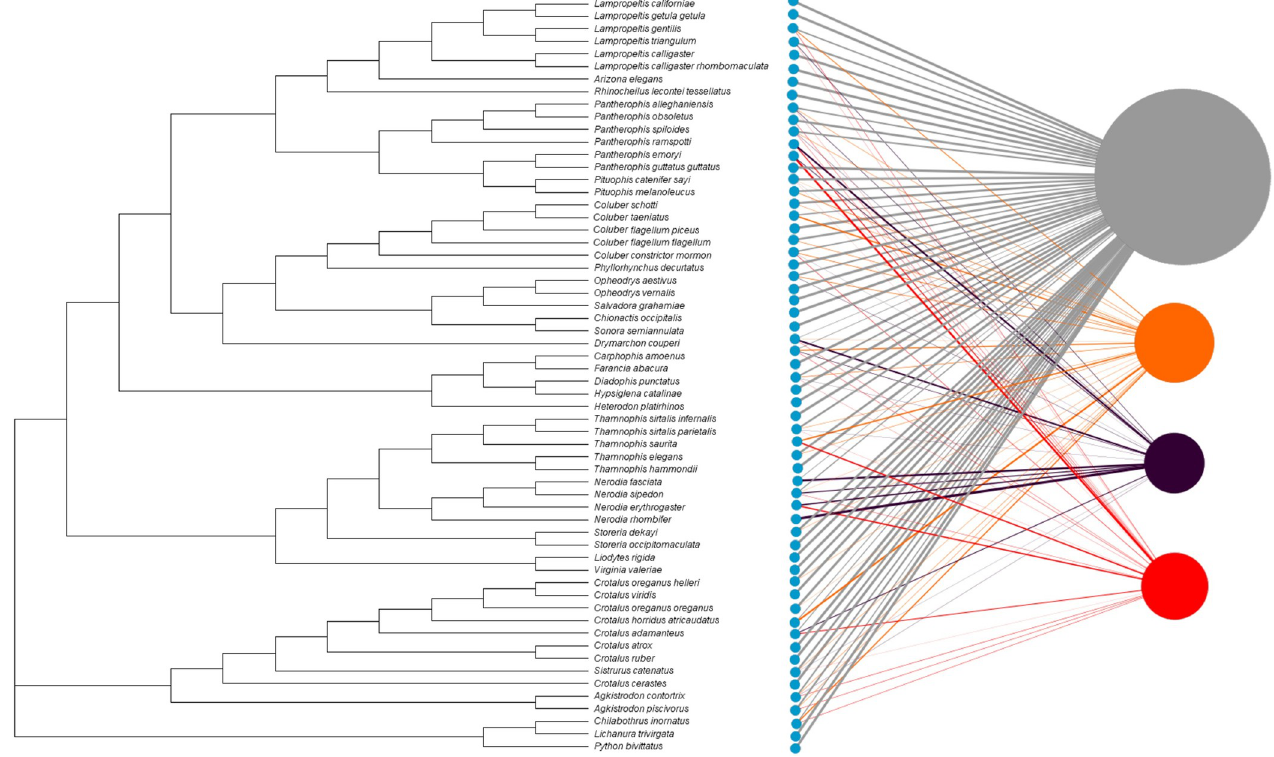
Fig 3. Phylogeny-based bipartite network for snakes sampled for ophidiomycosis on military lands in 2018. Blue nodes represent sampled snake species aligned with the corresponding leaf in the phylogenetic tree. The gray node represents the negative category, the orange node represents possible ophidiomycosis, the dark purple node represents Ophidiomyces present, and the red node represents apparent ophidiomycosis. A species node is connected to an ophidiomycosis node if snakes of a given species were classified into the given category. Node size is weighted by prevalence of the ophidiomycosis category, and links are weighted by the proportion of snakes of the given species in the given